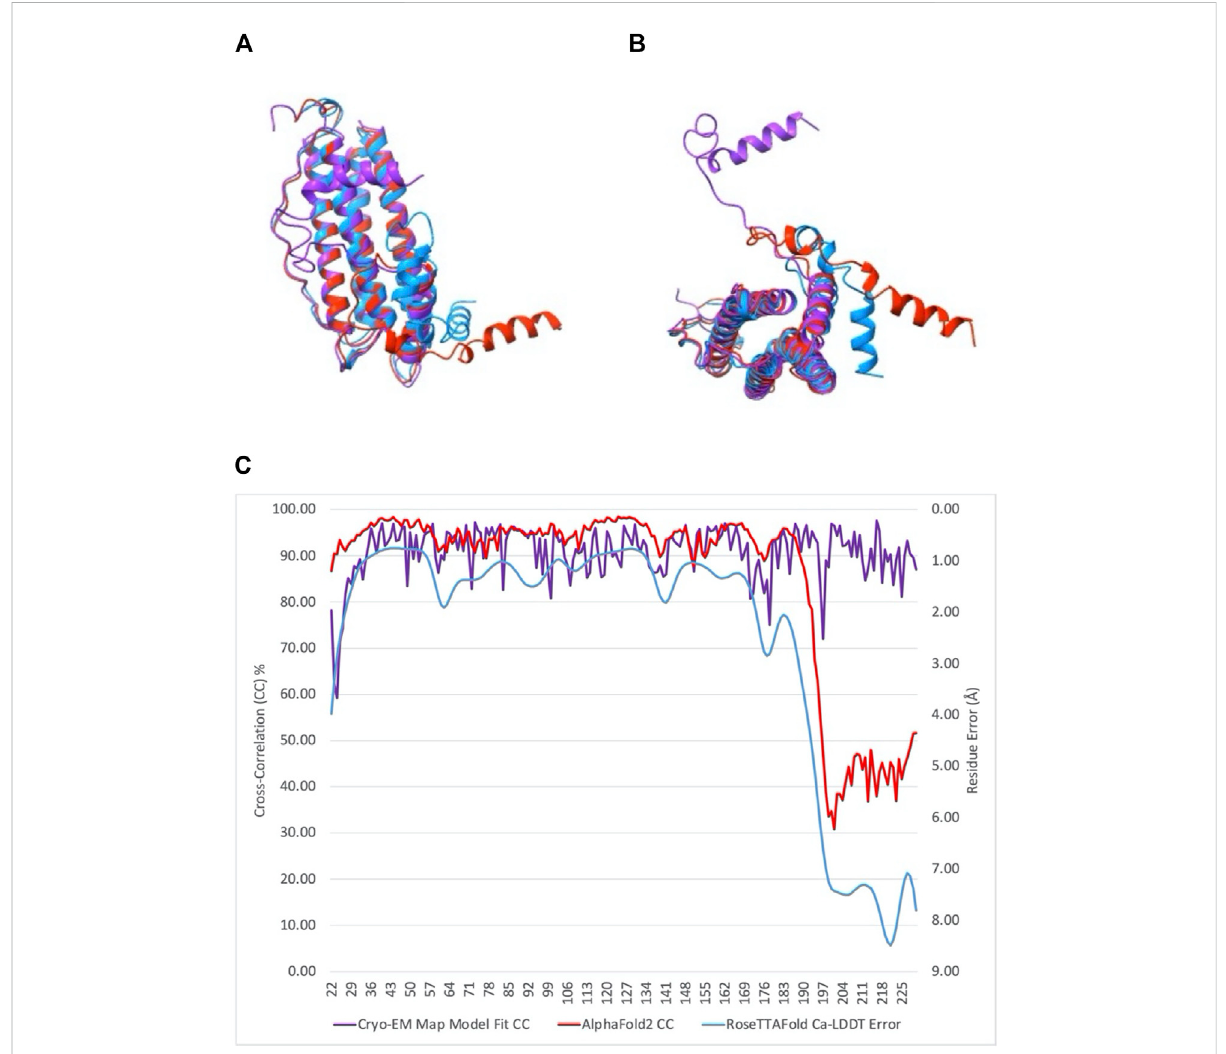
Comparison of the structure of artemin monomer with models obtained from AlphaFold2 and RoseTTAFold. (A) Final atomic model of artemin monomer calculated bydirect re fi nementand fi ttingwithin ourcryo-EM map (purple) overlaidatop modelsfrom AlphaFold2(red) andRoseTTAFold (blue). (B) 90-degree rotation of models in (A) . (C) Plot comparing correlation scores of cryo-EM map/model fi t and AlphaFold2 con fi dence scores per residue plotted against left axis, and RoseTTAFold per residue error in Å plotted against right axis. Colors for plots match the plots of the overlays in (A,B)